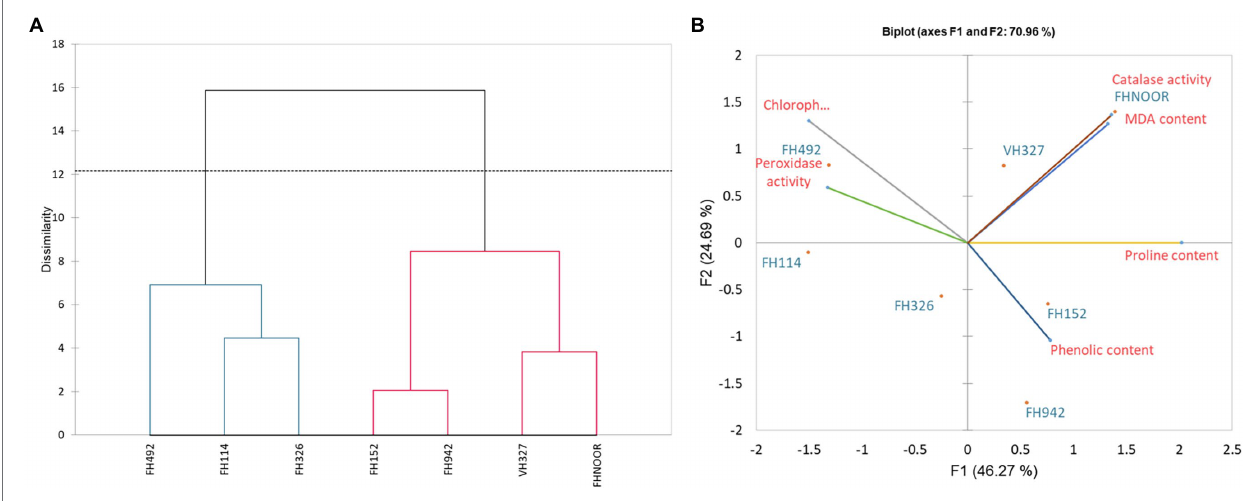
FIGURE 5 | Dendrogram representing the clustering (A) and Biplot showing contribution (B) of various physiological parameters in drought